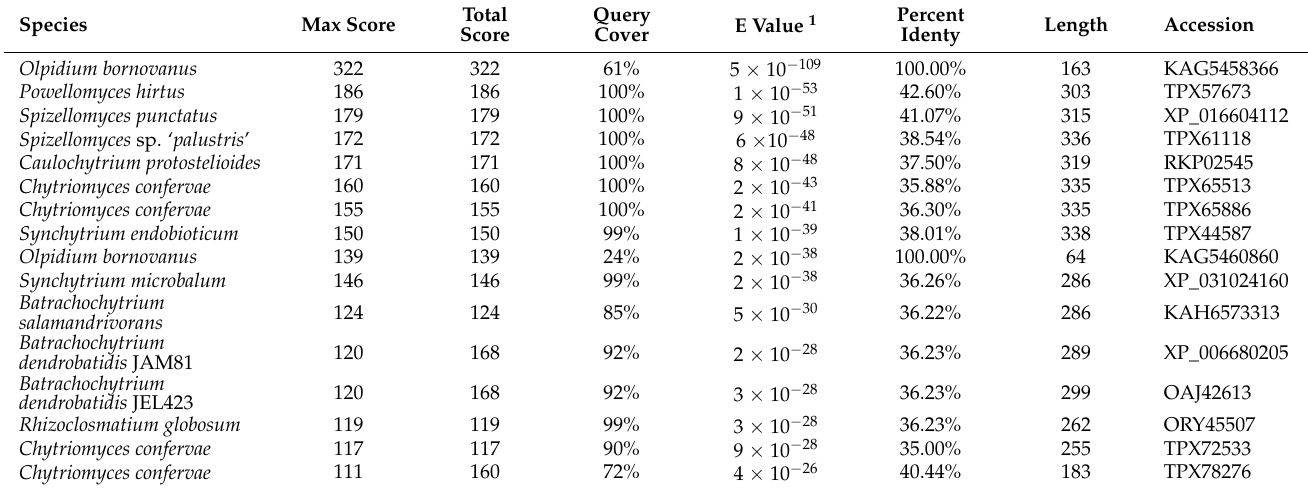
Table 2. Best protein hits when using Olpidium bornovanus KAG5460860 + KAG5458366 as a